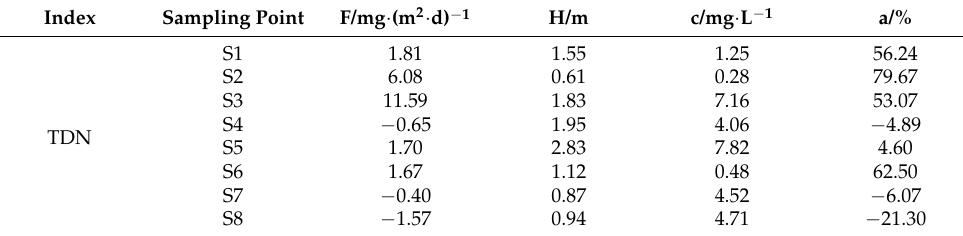
Table 9. Contribution rate of TDN nutrient diffusion at the sediment–water interface to the water body.